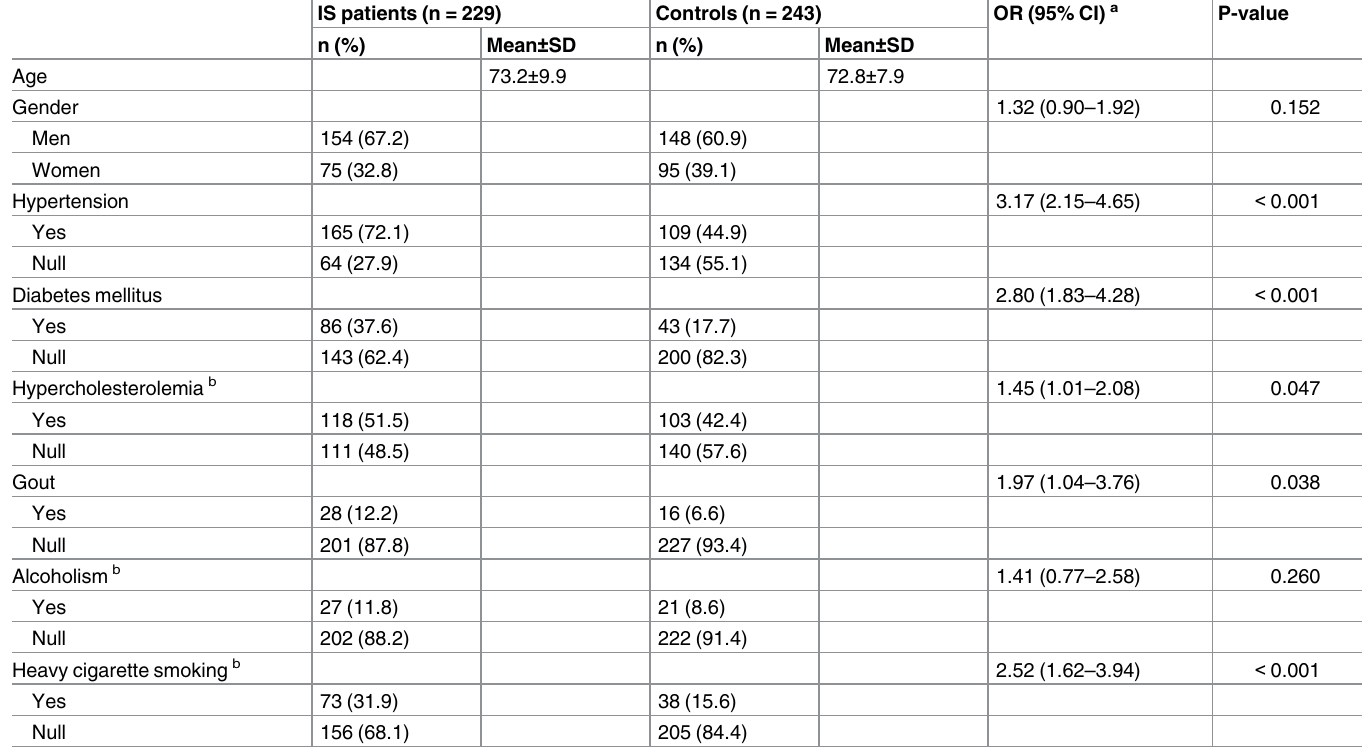
Table 1. Demographic data for the LAA stroke patients and control subjects. IS patients (n =